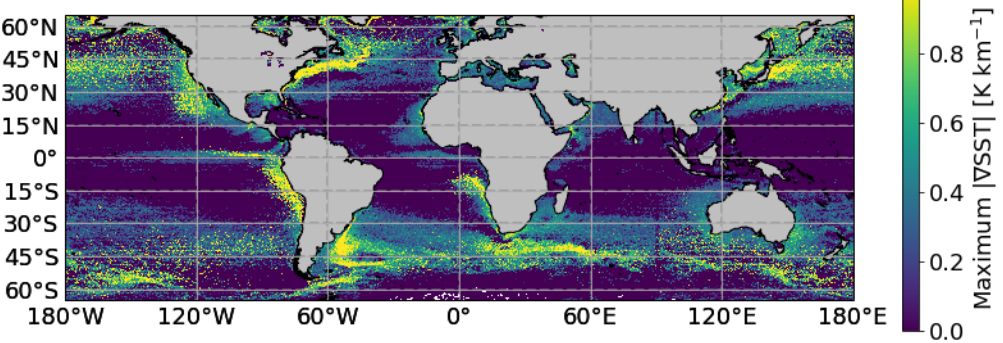
Figure 2. Maximum of the annual climatology of the maximum spatial gradient of SST from University of Rhode Island (URI) Pathfinder 9 km frontal